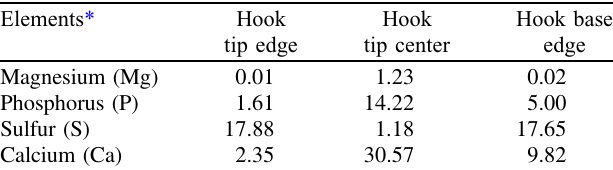
Table 5. X-ray scans for chemical elements of a Gallium cut spine of Rhadinorhynchus